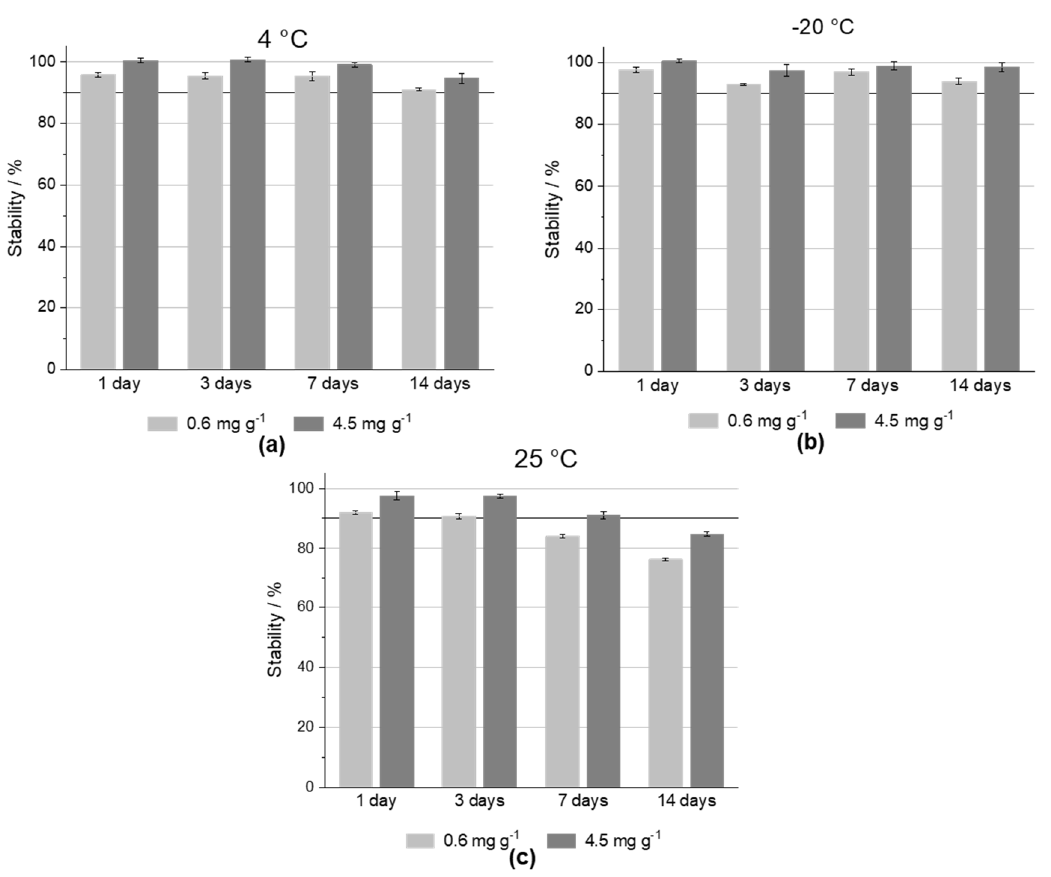
◦ C, ( b ) 4 ◦ C, and ( c ) − 20 ◦